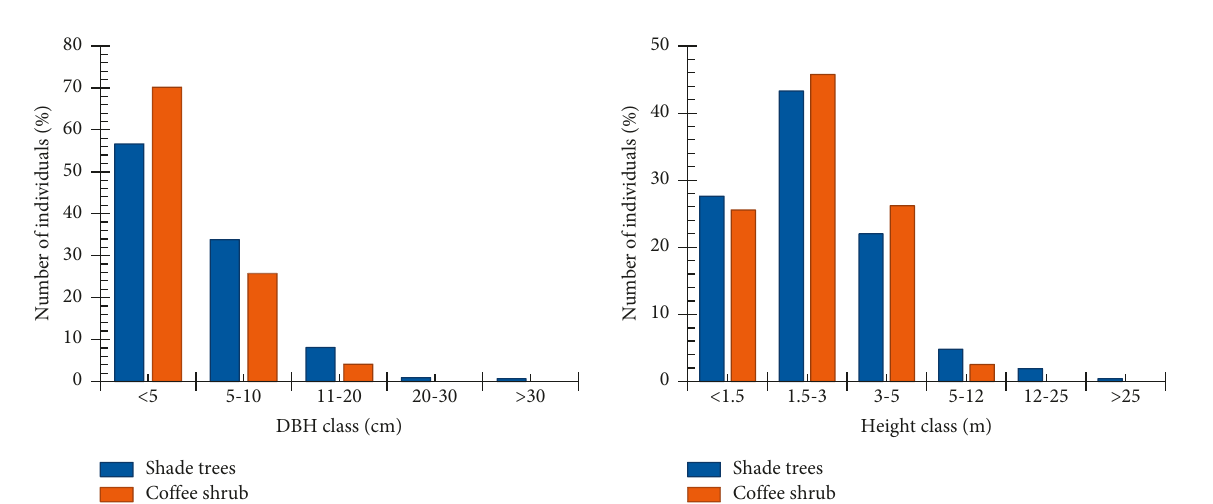
Species and Soil Organic Carbon. In the traditional coffee- based agroforestry system AGB of shade trees showed a significant ( p < 0 . 05)) difference along the elevation gradi- ent, whereas AGB of coffee shrub did not vary significantly ( p < 0 . 05) (Table 5). The highest (34.24 Mg ha − 1 ) and the lowest (14.10 Mg · ha − 1 ) shade trees AGB was found at the